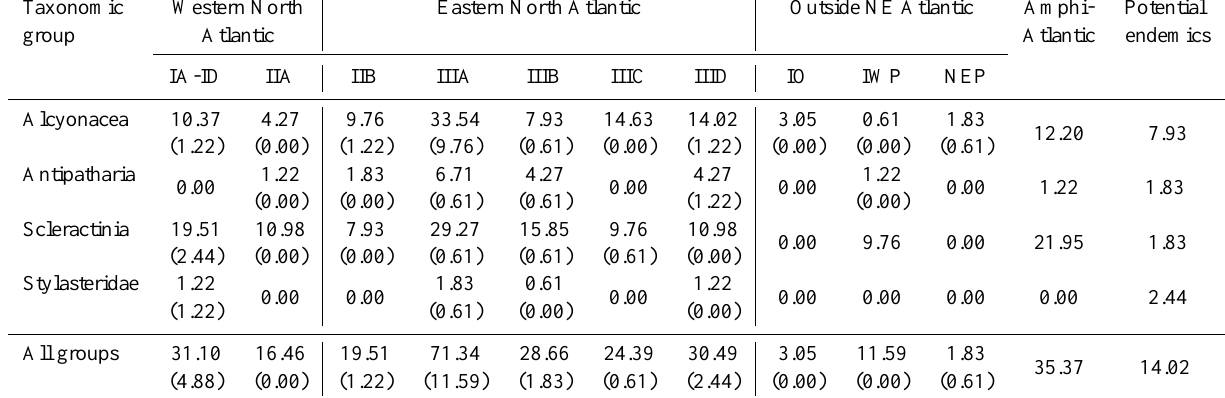
Table 5. Zoogeographic affinities of the coral fauna of the Azores EEZ. Values represent the percentage of faunal composition shared with each geographical region (in brackets is the percentage of species only found in that region, besides the Azores). Regions are adapted from Cairns and Chapman (2001) and Watling et al. (2011): IA-ID – western North Atlantic, Cape Hatteras to Florida Straits, Antilles, Caribbean, Gulf of Mexico, Guyana to tropical coast of Brazil; IIA – western North Atlantic, southern Greenland, East Canada from Baffin Island and Davis Strait to Cape Hatteras; IIB – boreal eastern Atlantic; IIIA – Lusitanian–Mediterranean; IIIB – seamounts south of the Azores and between Portugal and Madeira; IIIC – West Africa, Mauritania, Senegal and Gulf of Guinea; IIID- Canary Islands and Cape Verde; IO